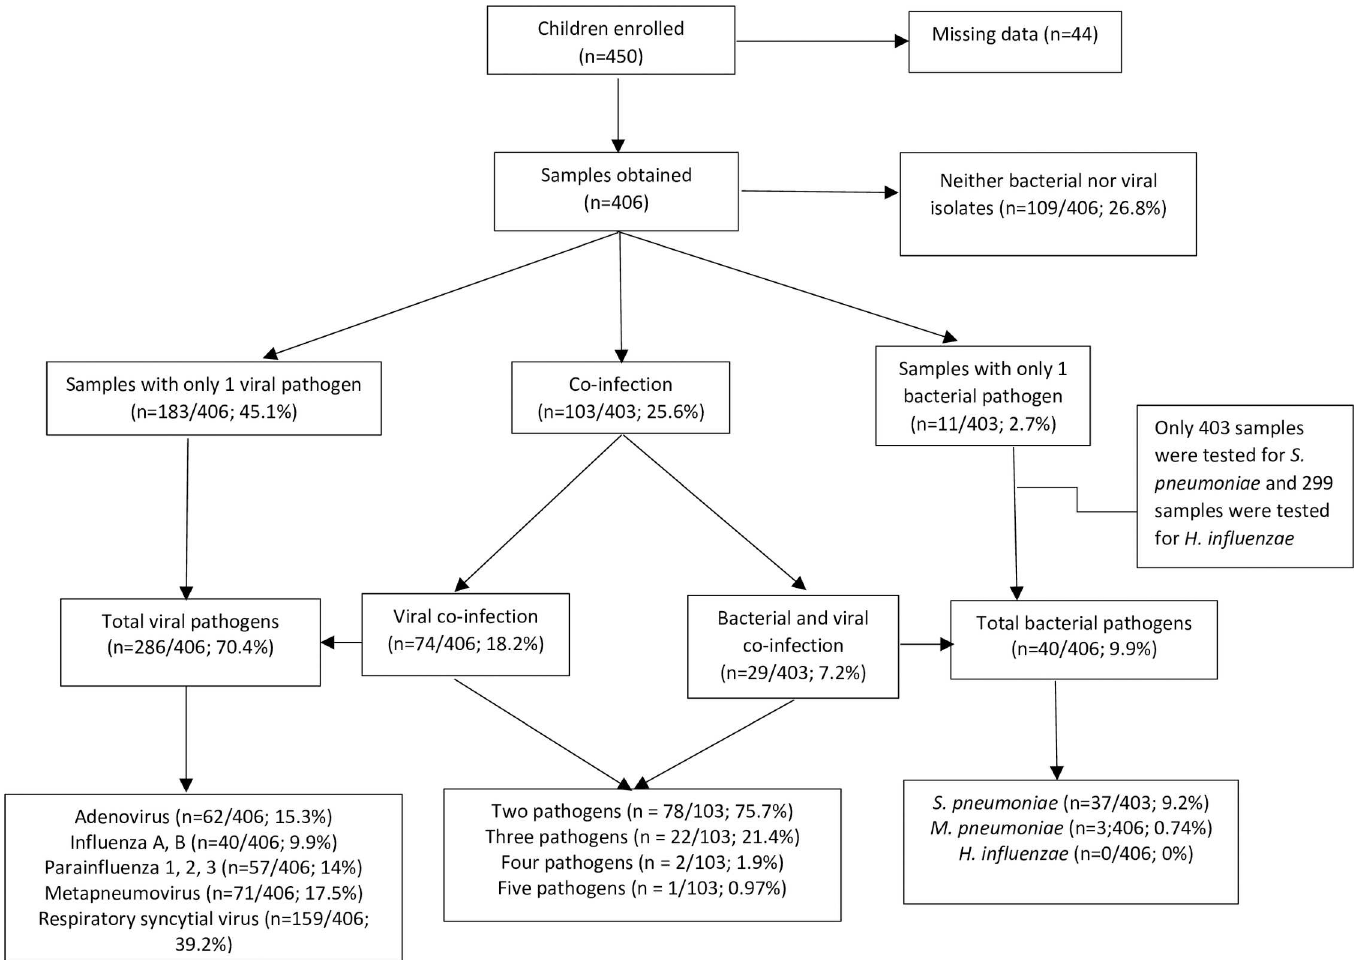
Fig 1. Study profile and analysis of sample